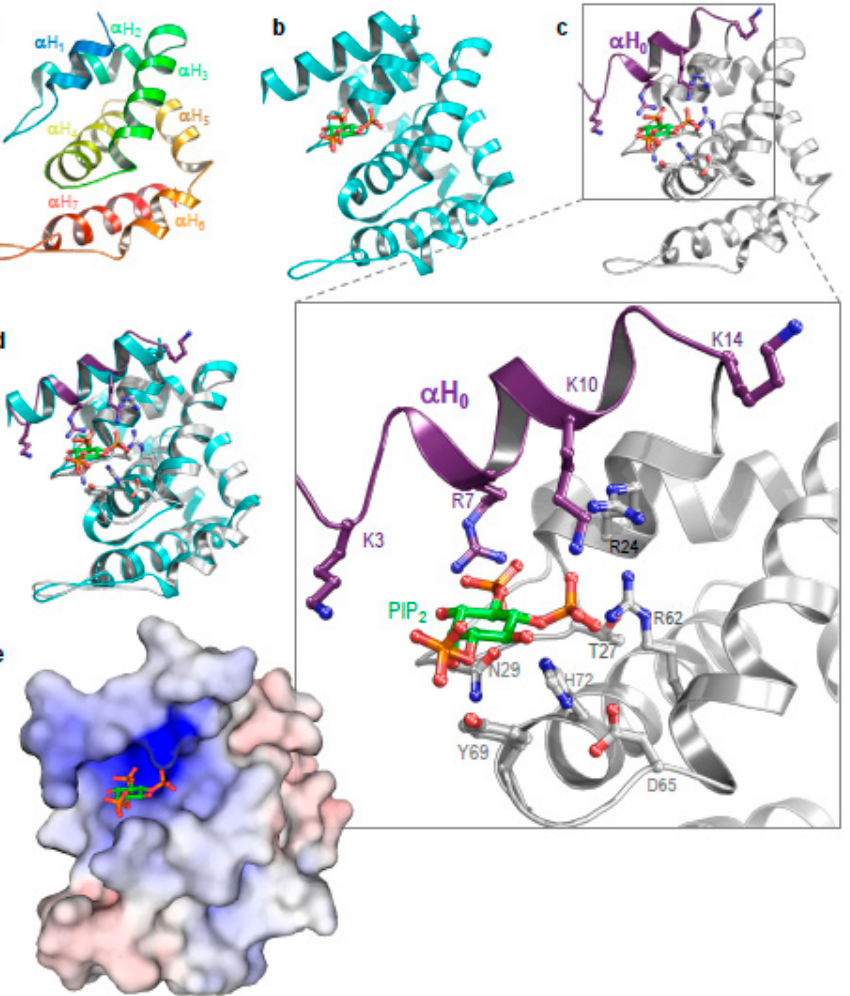
Figure 3. Structural insight into an ENTH domain. ( a ) The apo structure of Ent1-ENTH (PDB code 5LOZ). ( b ) The structure of a rat Epsin1–ENTH domain in complex with phosphatidylinositol-4,5-bisphosphate (PIP 2 ; PDB code 1H0A). ( c ) A homology-based model of a yeast Ent1-ENTH domain with PIP 2 . Zooming in on the binding site shows the residues that interact with PIP 2 and K3. ( d ) The superposition of the yeast Ent1 model with rat Epsin1. ( e ) An electro-potential surface representation of the yeast Ent1–ENTH domain. PIP 2 is accommodated in a positively charged pocket (blue).